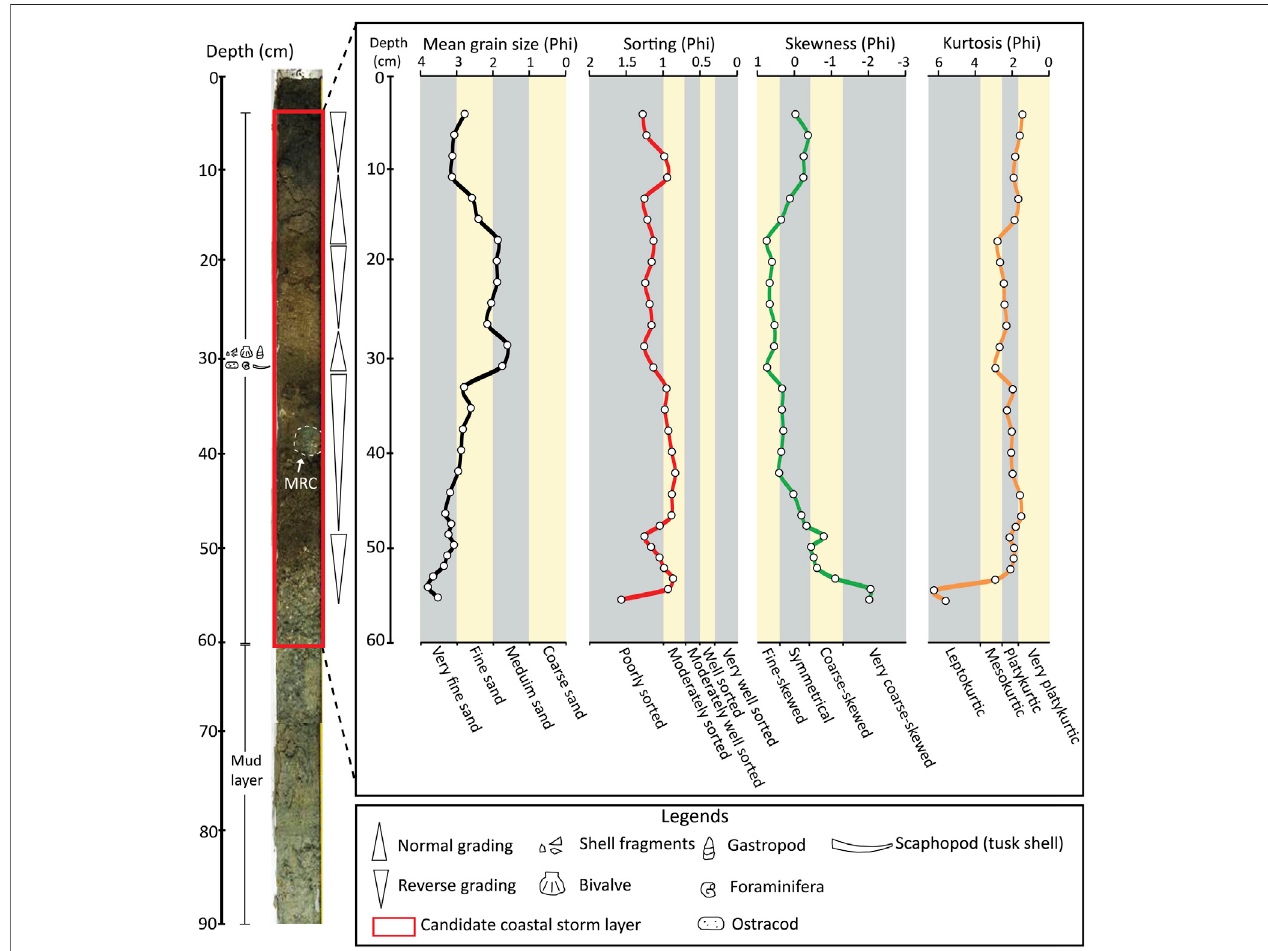
FIGURE 6 | Stratigraphy of core 2 with a vertical plot of the mean grain size, sorting, skewness and kurtosis. See details of the sedimentary structures of core 2 (square box) in Figure 5D – F .